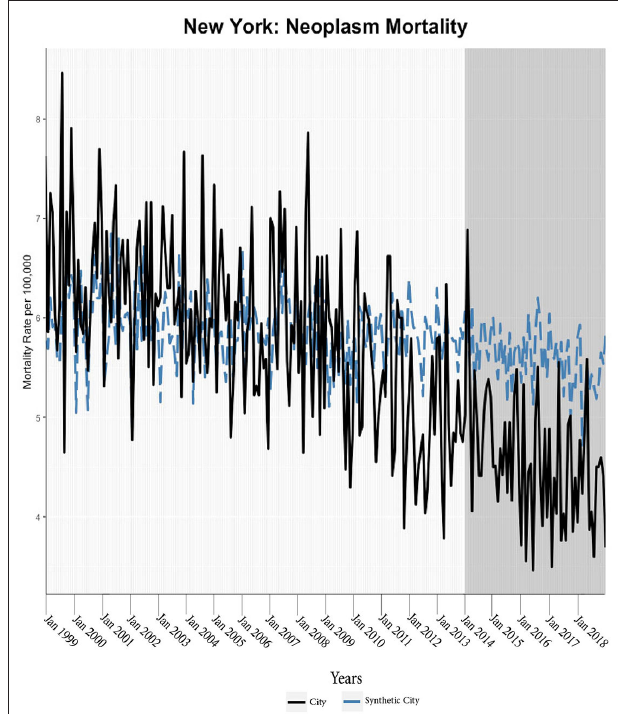
FIGURE 7 | Neoplasm mortality trends: Baltimore and synthetic control city.